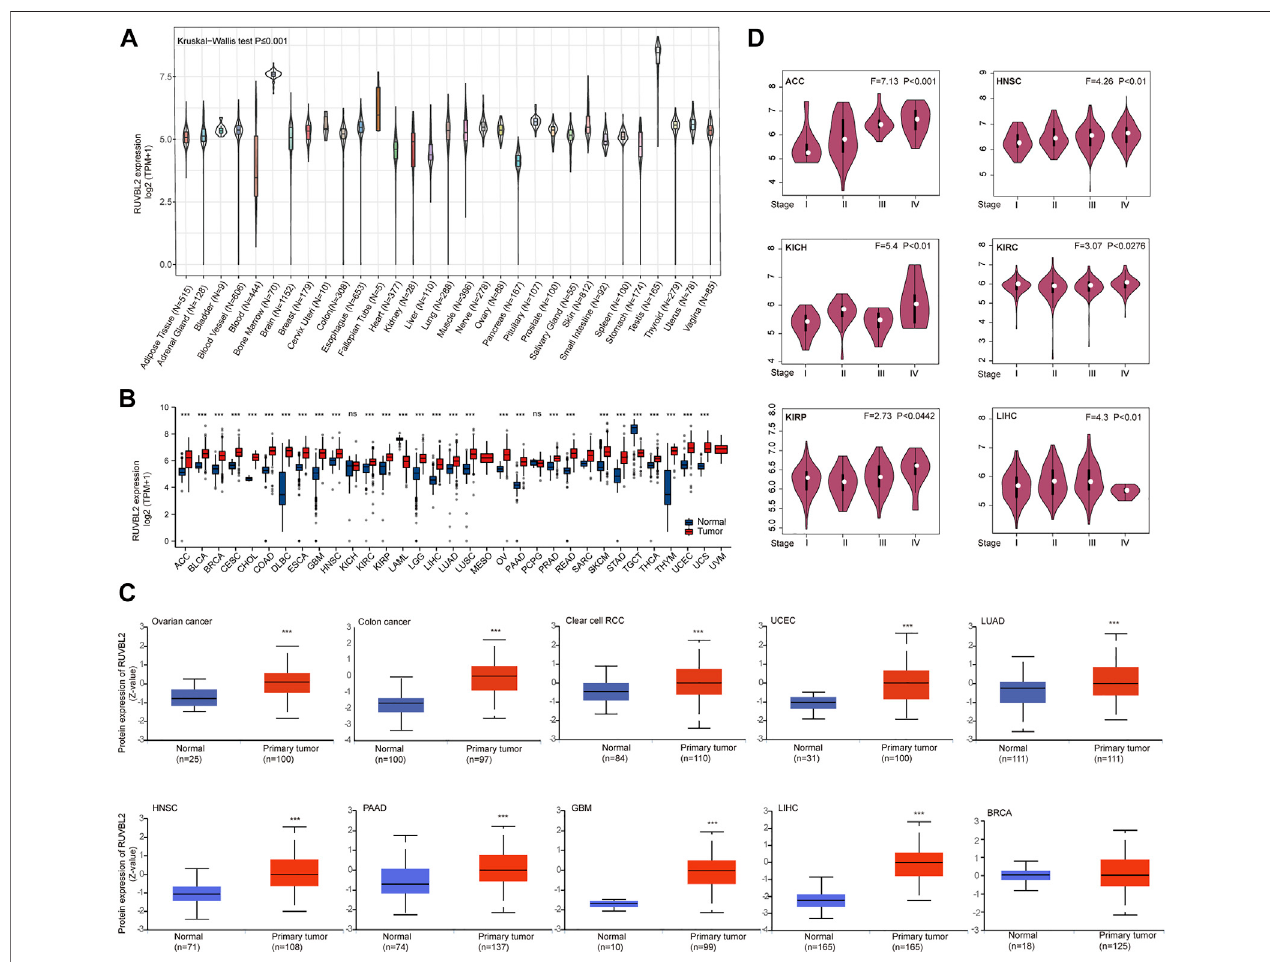
FIGURE 1 | Differential expression of Reptin. (A) The expression of Reptin in normal human tissues. (B) The expression of Reptin in 33 types of TCGA cancer. (C) The protein level of Reptin in BRCA, OV, COAD, RCC, UCEC, LUAD, HNSC, PAAD, GBM, and LIHC. (D) The expression of Reptin in pathological stages I-IV of ACC, HNSC, KICH, KIRC, KIRP, and LIHC. * p < 0.05, ** p < 0.01, *** p < 0.001.